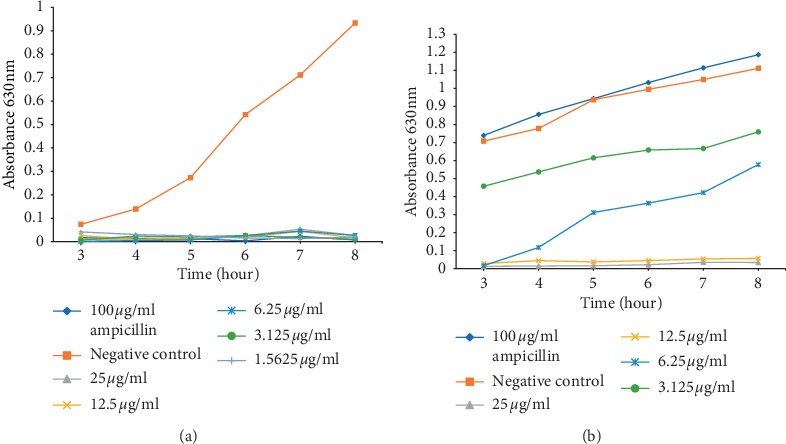
Growth-inhibitory effects of Molecule 3 against P. aeruginosa (ATCC 22108) and K. pneumoniae (ATCC 700603). (a) The time curve of Molecule 3 against P. aeruginosa (ATCC 22108). (b) The time curve of Molecule 3 against K. pneumoniae (ATCC 700603). The tested strain was cultured in 96-well plates, and the OD620 was measured at each time point. The error bars indicate standard deviations from the mean.